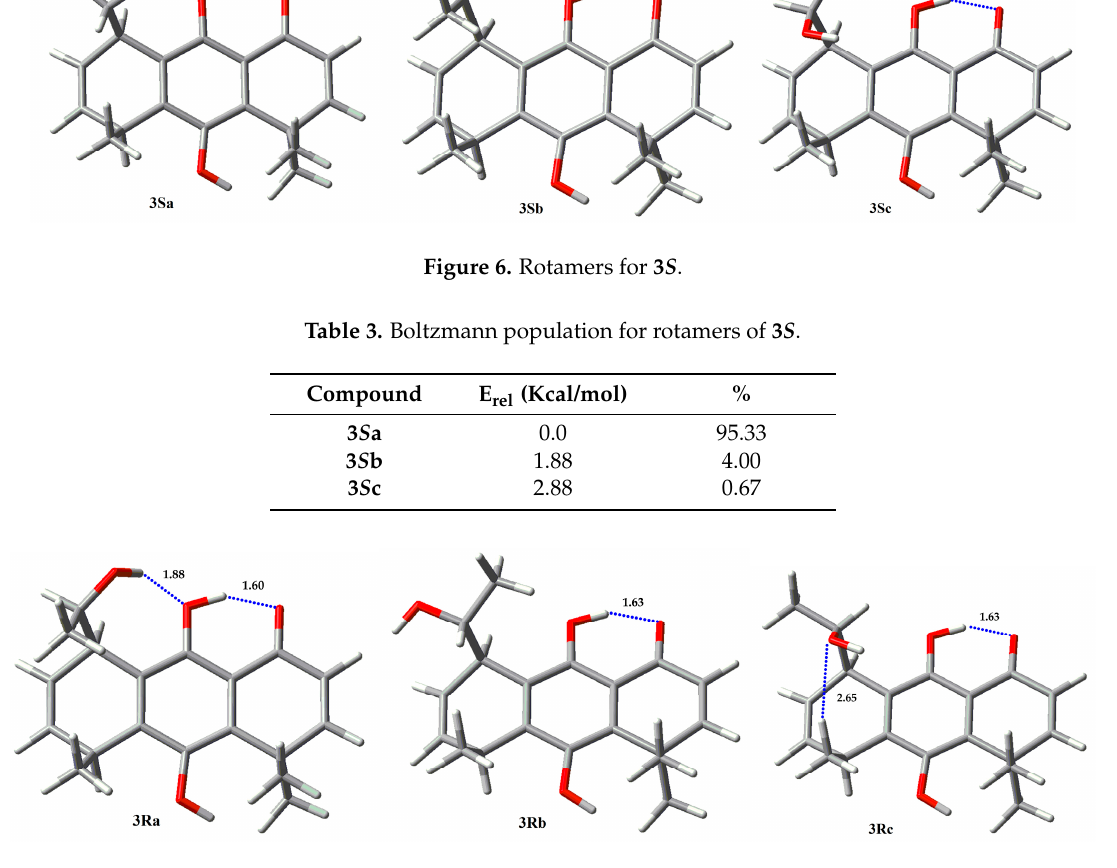
Figure 7. Rotamers for 3 R .